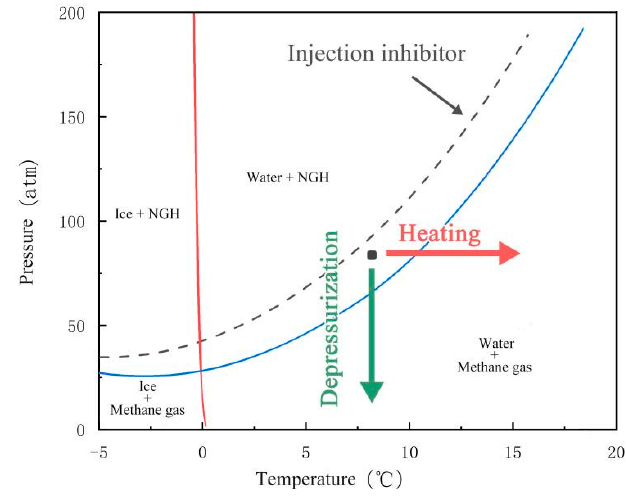
Figure 4. NGH three-phase balance curve [8].